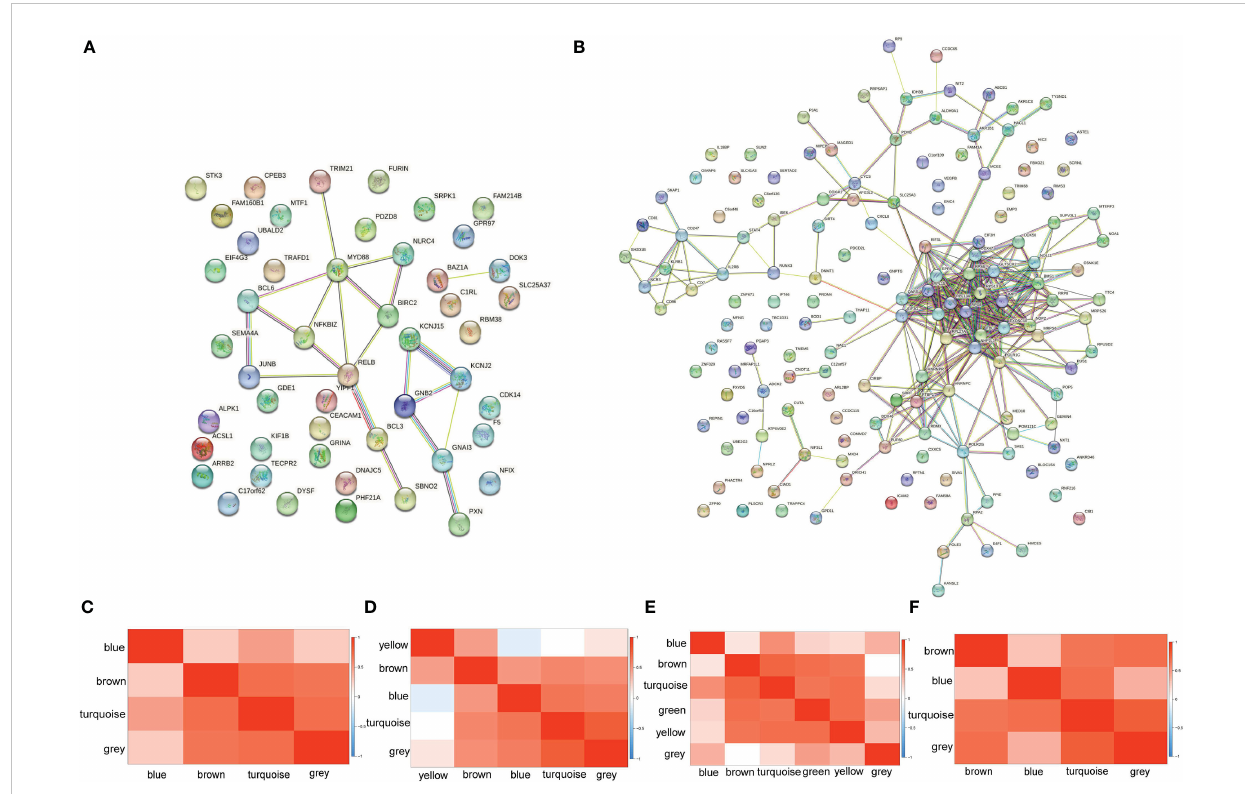
FIGURE 3 PPI network and WGCNA (A) PPI network of up-regulated coDEGs. (B) PPI network of down-regulated coDEGs. (C) Correlation between up- regulated gene modules in AS. (D) Correlation between down-regulated gene modules in AS. (E) Correlation between up-regulated gene modules in IBD. (F) Correlation between down-regulated gene modules in